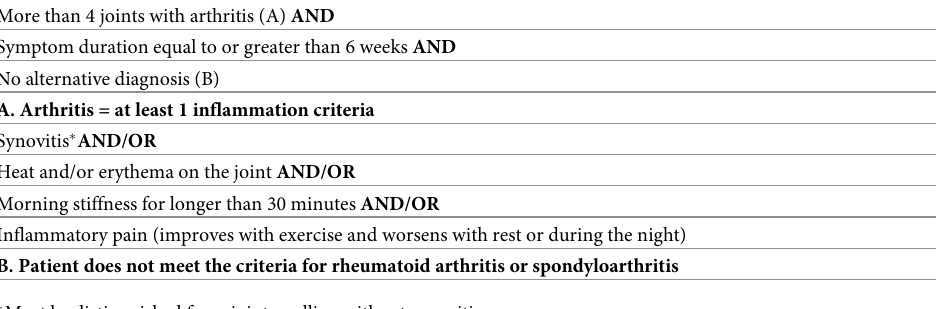
Table 1. Criteria for classification of post–Chikungunya chronic inflammatory joint disease